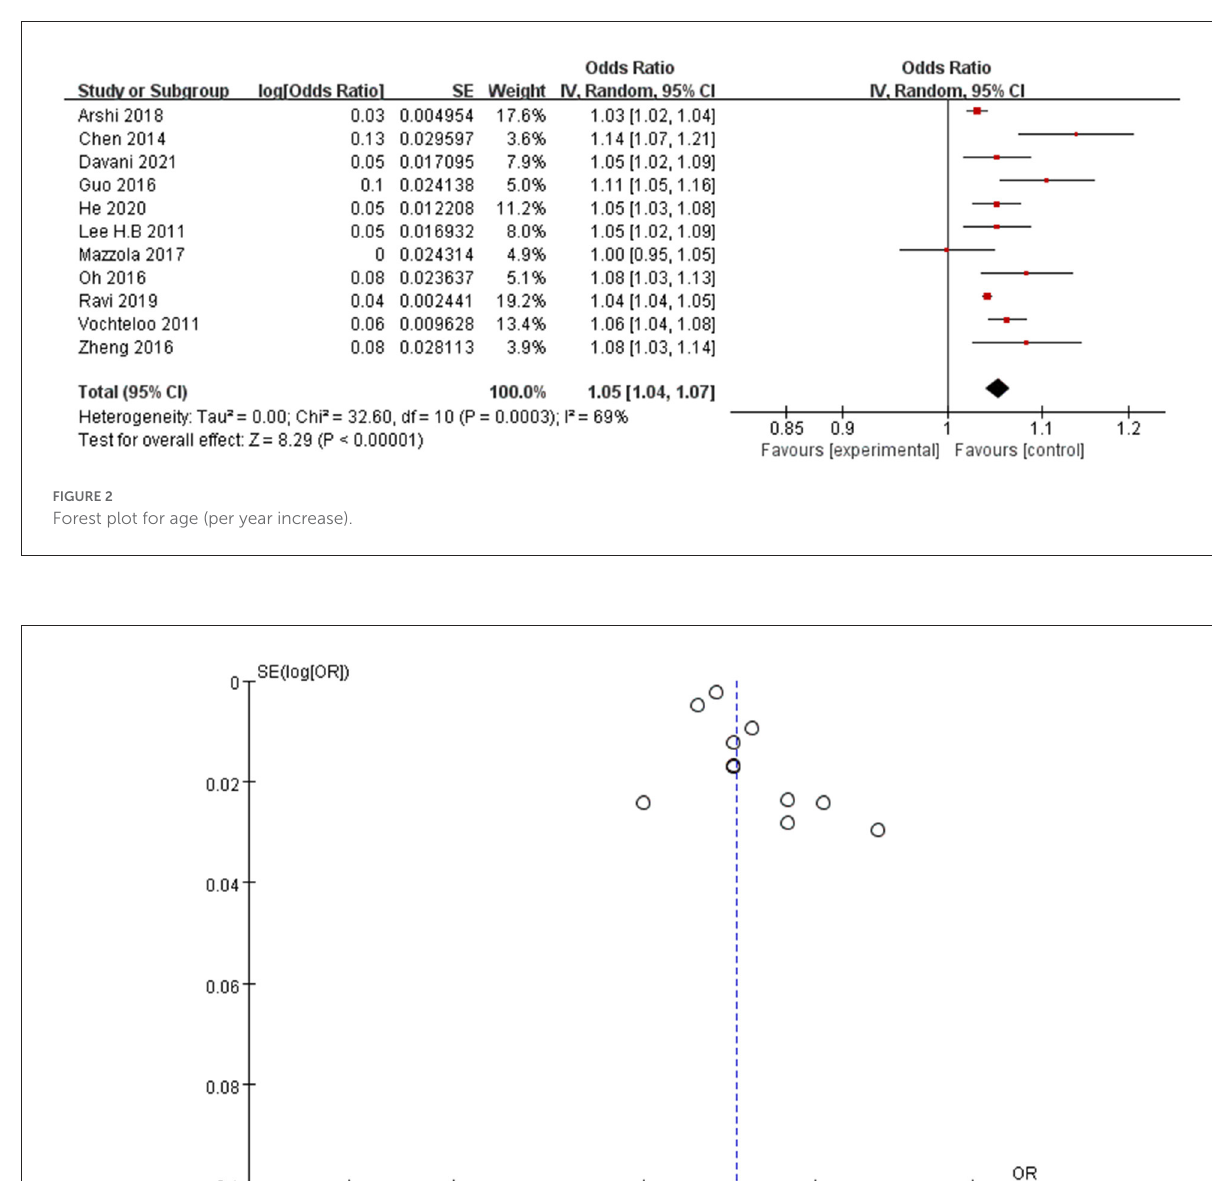
FIGURE3 Funnel plot for age (per year increase) for the investigation of publication